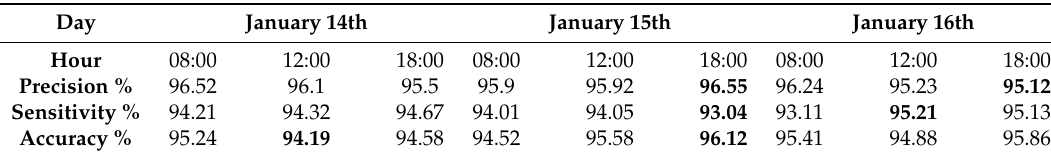
Table 6. Statistical analysis of hot-spot detection algorithm.